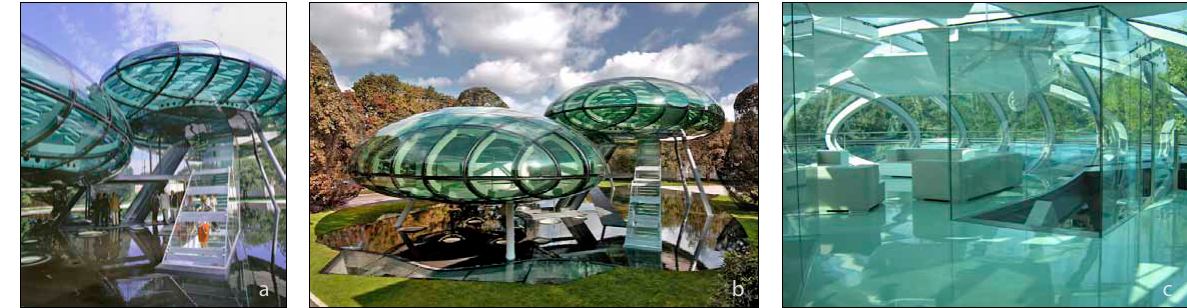
fig. 5. nardini research Center and auditorium, Bassano Del Grappa,